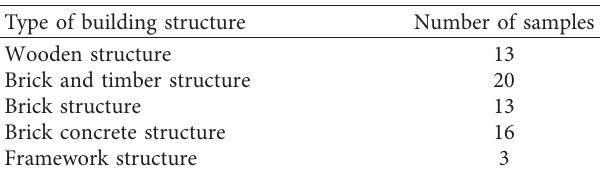
Figure 1: Distribution of survey points and sample Table 2: The type and number of the building.